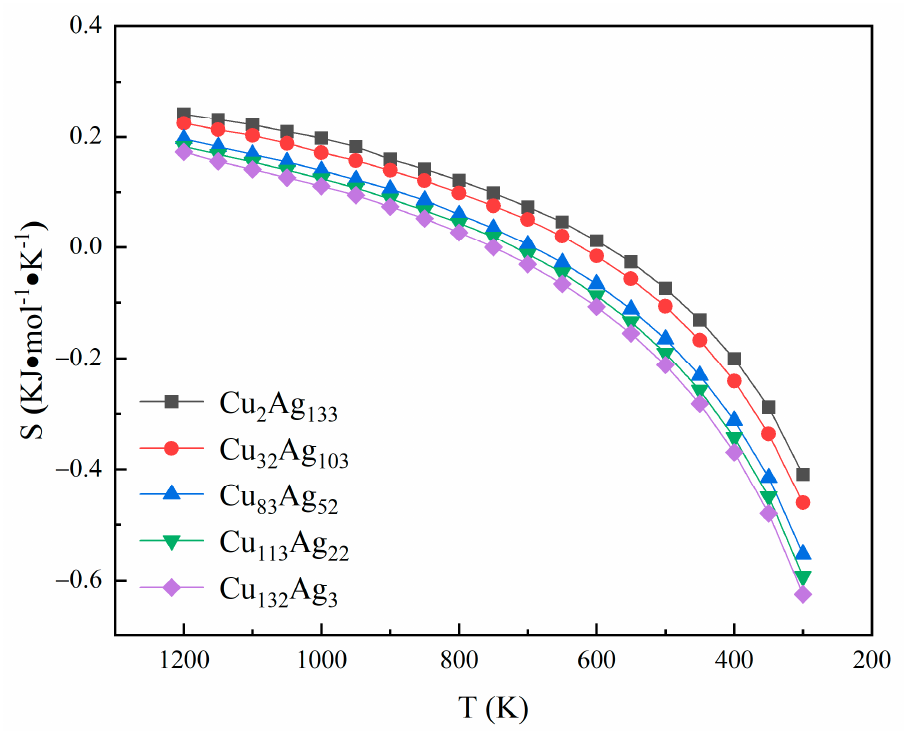
Figure 6. Entropy curves of five clusters with temperature. Figure 7 shows the rotational free energy variation of the five clusters Cu 2 Ag 133 , Cu 32 Ag 103 , Cu 83 Ag 52 , Cu 113 Ag 22 , and Cu 132 Ag 2 at different temperatures with time. The free energy referred to here is composed of translational free energy and rotational free energy. At one temperature, the rotational free energy varies significantly, while the translational motion is temperature dependent, and its value is a constant. The free energy from the rotation is given by − k B T × ln Zr , where k B is the Boltzmann constant, T temperature, and Zr rotational partition function. For the Cu 2 Ag 133 cluster, the free energy of the cluster fluctuates in the 0 to 0.5 ns time range at 850 K, increases significantly in the subsequent 0.1 ns, and then gradually flattens out. At 600 K, the free energy of Cu 32 Ag 103 cluster fluctuates more significantly in the 0 to 0.1 ns and 0.45 to 0.5 ns time ranges, except for the pronounced fluctuations in the other time, and tends to level off in the other time. In these time regimes that the free energy values change more significantly, the conformations of the cluster change significantly, indicating the occurrences of packing transition. The free energy of Cu 83 Ag 52 clusters at 800 K showed a largely fluctuating between 0 and 0.95 ns, suggesting that followed conformational variations in this time regime, atomic packing becomes stable. At 600 K, the free energy of Cu 113 Ag 22 clusters show that the packing transition occurs in a short time regime of 0.35 nm. For the Cu 132 Ag 3 cluster, at 950 K, the free energy changes dramatically at the time range of 0–0.6 ns, suggesting occurrences of a large number of conformations. The free energy changes of the five clusters at 300 K are similar, i.e., they increase slowly with increasing time, where the Cu 2 Ag 133 cluster has the smallest free energy value, followed by the Cu 32 Ag 103 , Cu 83 Ag 52 , Cu 113 Ag 22 clusters, and the Cu 132 Ag 2 cluster has the largest free energy